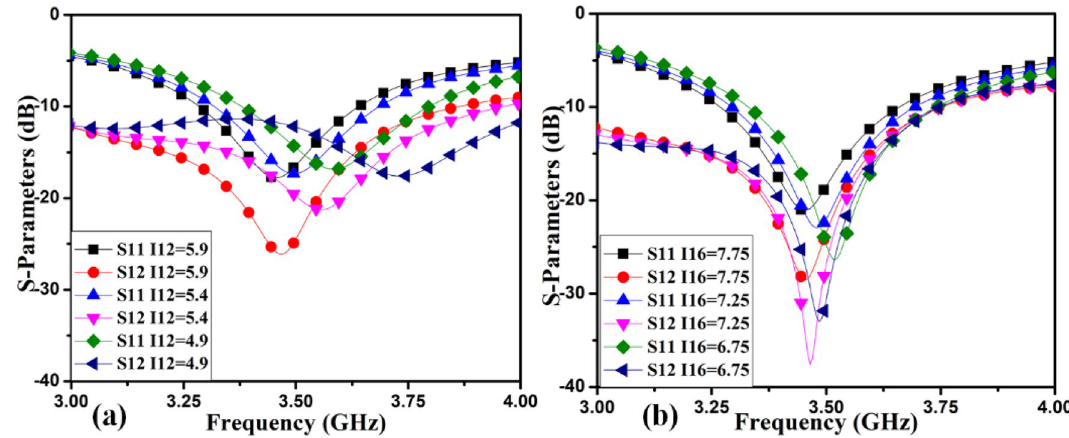
Figure 14. Simulated S-parameter parametric results ( a ) I12 variation, ( b ) I16 variation.